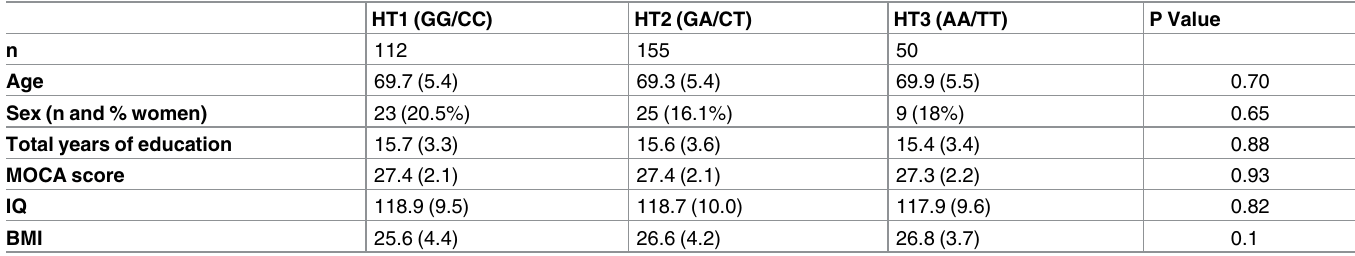
Table 3. Comparisons of socio-demographic variables between the haplotype groups included in the neuroimaging analysis.